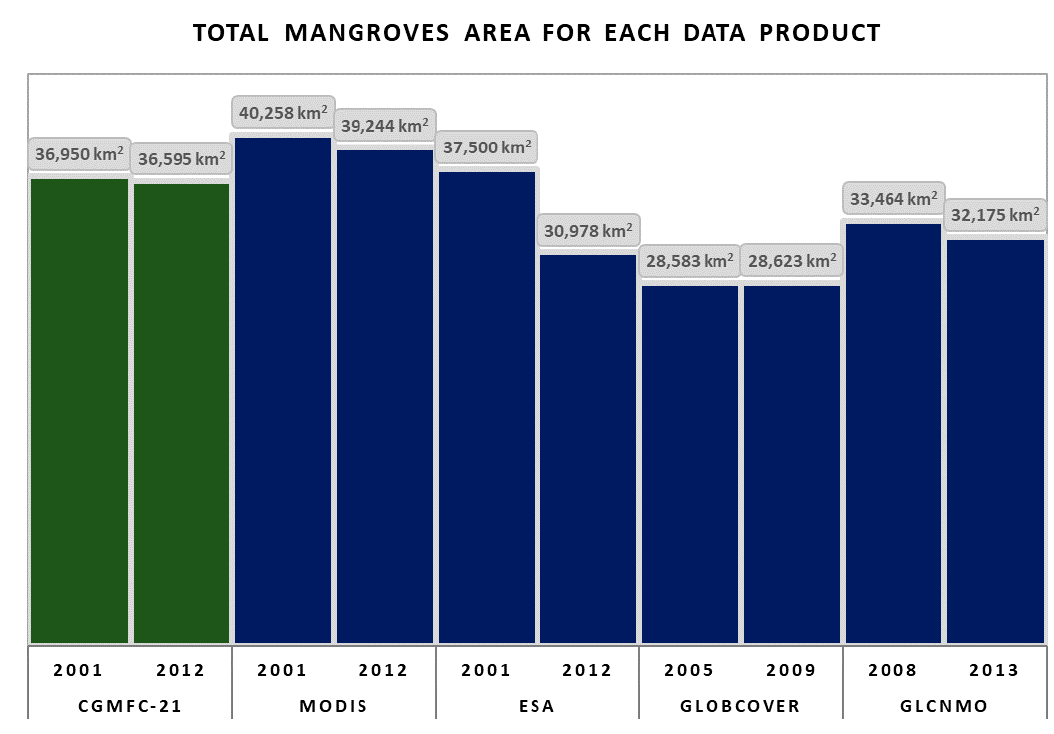
Figure 14. Total area of mangrove forest class of each GLC product.